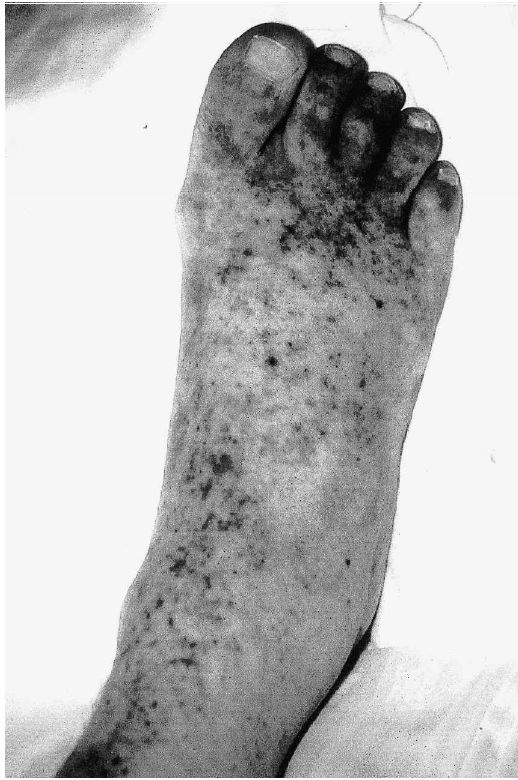
Figure 1 Patient 1 on readmission: petechial rash of right foot